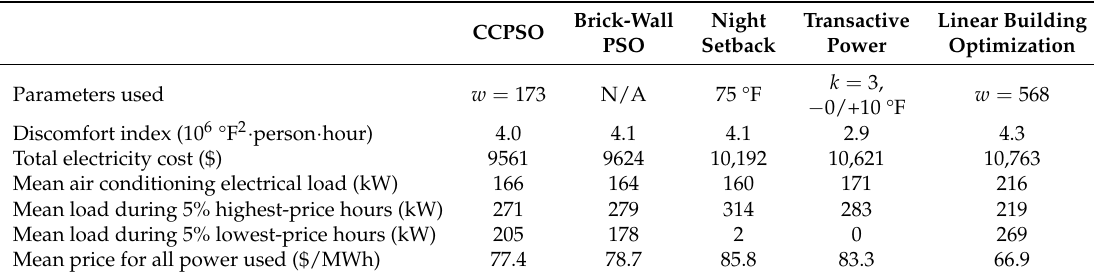
Table 1. Electricity expenditure, discomfort, and quantity and timing of electricity use during August 2007, for several control strategies with similar comfort